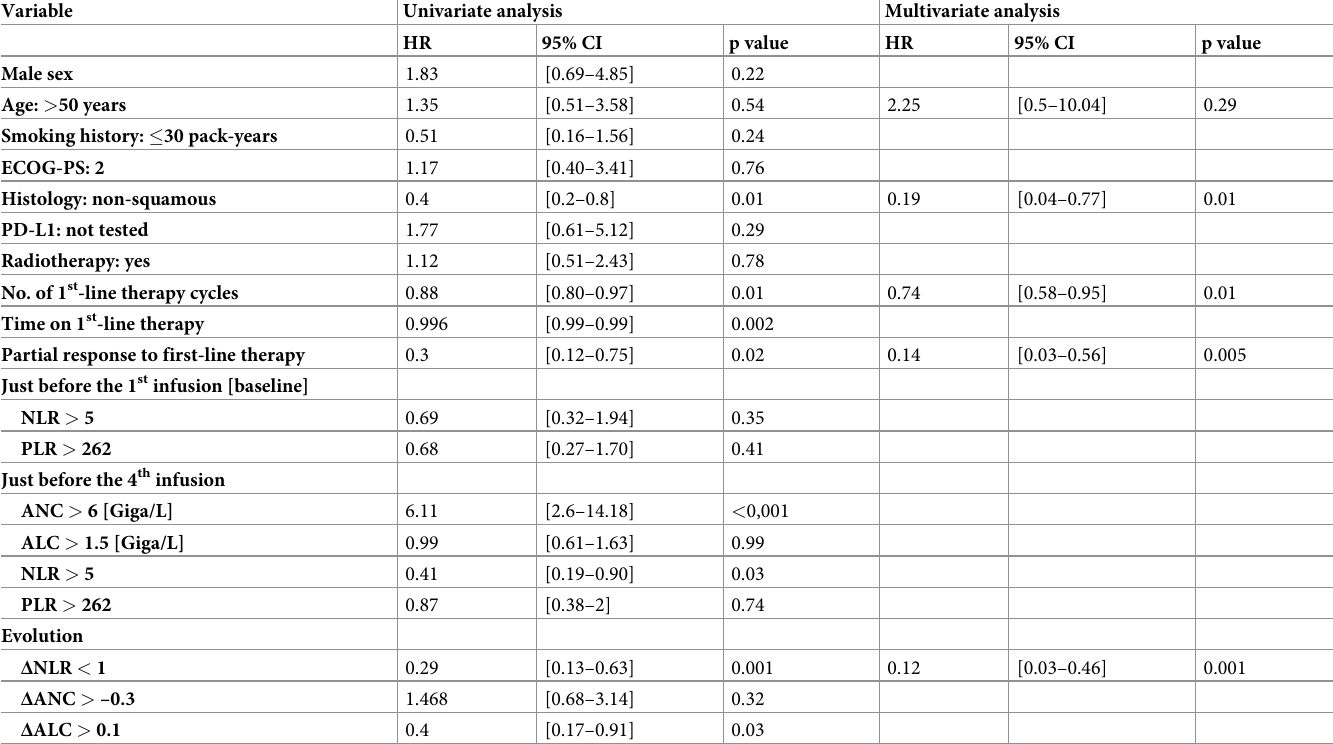
Table 3. Univariate and multivariate analysis of overall